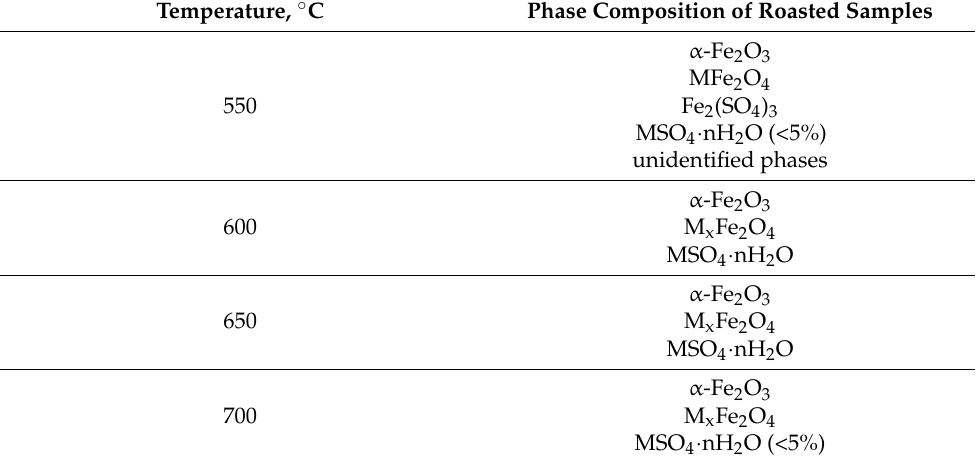
Table 6. General results of XRD analysis of the samples obtained in the experiments in the systems MFe 2 O 4 –FeSO 4 · 7H 2 O and MFe 2 O 4 –Fe 2 (SO 4 ) 3 · 9H 2 O, where M is Zn, Cu or Zn 0.5 Cu 0.5 , at 550–700 ◦ C for 60–240 min in molar ratios from 1:0.5 to 1:4 excluding hydrated moisture. Temperature, ◦ C Phase Composition of Roasted Samples 550